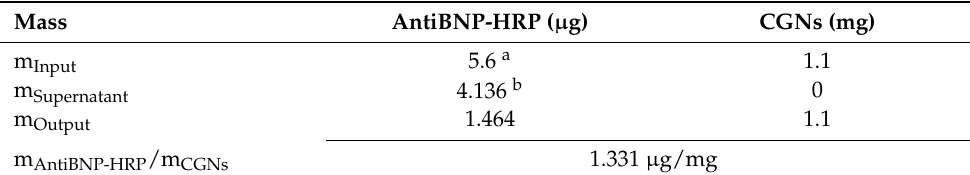
Table 1. The ratio of m AntiBNP-HRP to m CGNs in the CGNs@AntiBNP-HRP immunoprobe. Mass AntiBNP-HRP ( µ g) CGNs (mg) m Input m